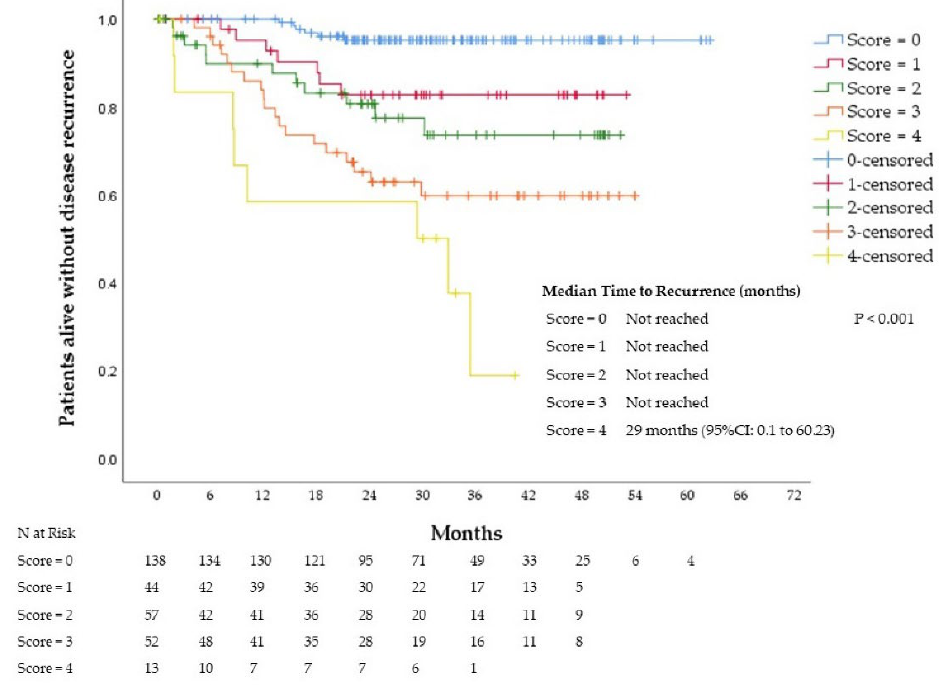
Figure 3. Time to recurrence according to risk groups (low-risk vs high-risk) in the training cohort. HR, hazard ratio; CI, confidence interval. A total of 100 patients were included in the validation cohort. The baseline character- istics are depicted in Table 1. The median age at diagnosis was 75 years (range 45–97), and 50% of the patients were female. The primary tumor was distributed equally in the right and left colon. Stage II was observed in 54% percent of the patients each. Twenty-one per- cent of the patients had high tumor budding. A total of 43 patients received adjuvant chemotherapy. Patients were assigned to the low-risk ( n = 46; 46%) and high-risk ( n = 54; 54%) groups. After a median follow-up of 15 months (range, 2 to 25 months), 15 (15%) of the patients had a first tumor recurrence. Recurrences were observed in five (9%) patients